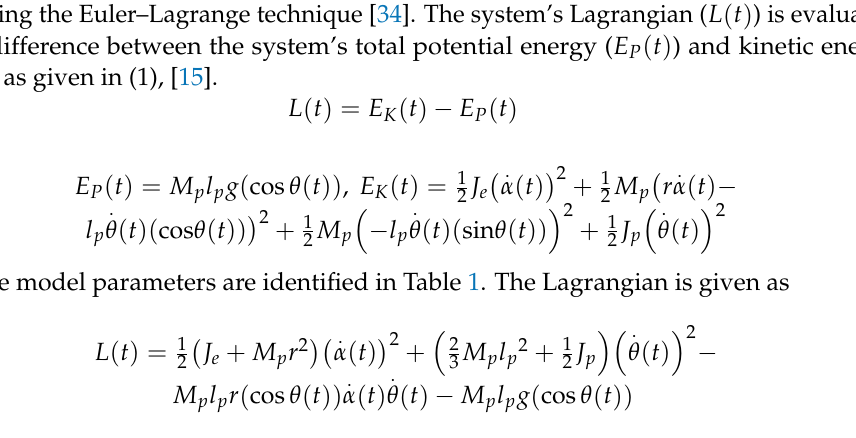
Table 1. Model parameters of QNET rotary